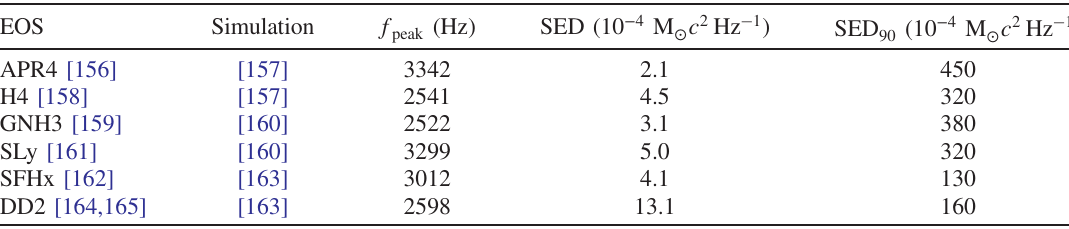
TABLE III. Numerical simulations of the 1 . 35 M ⊙ – 1 . 35 M ⊙ binary neutron star mergers with different EOSs shown in Fig. 13. We report the value of the SED from each simulation at the peak frequency f credible upper limit on the SED at that frequency. The distance D L ¼ 44 . 74 Mpc and inclination θ JN ¼ 166 . 05 deg are determined from the point of maximum posterior probability sampled from the PhenomPNRT model. Note that this is the maximum posterior probability sample drawn from the full posterior probability distribution, and it does not necessarily correspond to the maxima of the 1D and 2D marginal distributions shown in Fig.